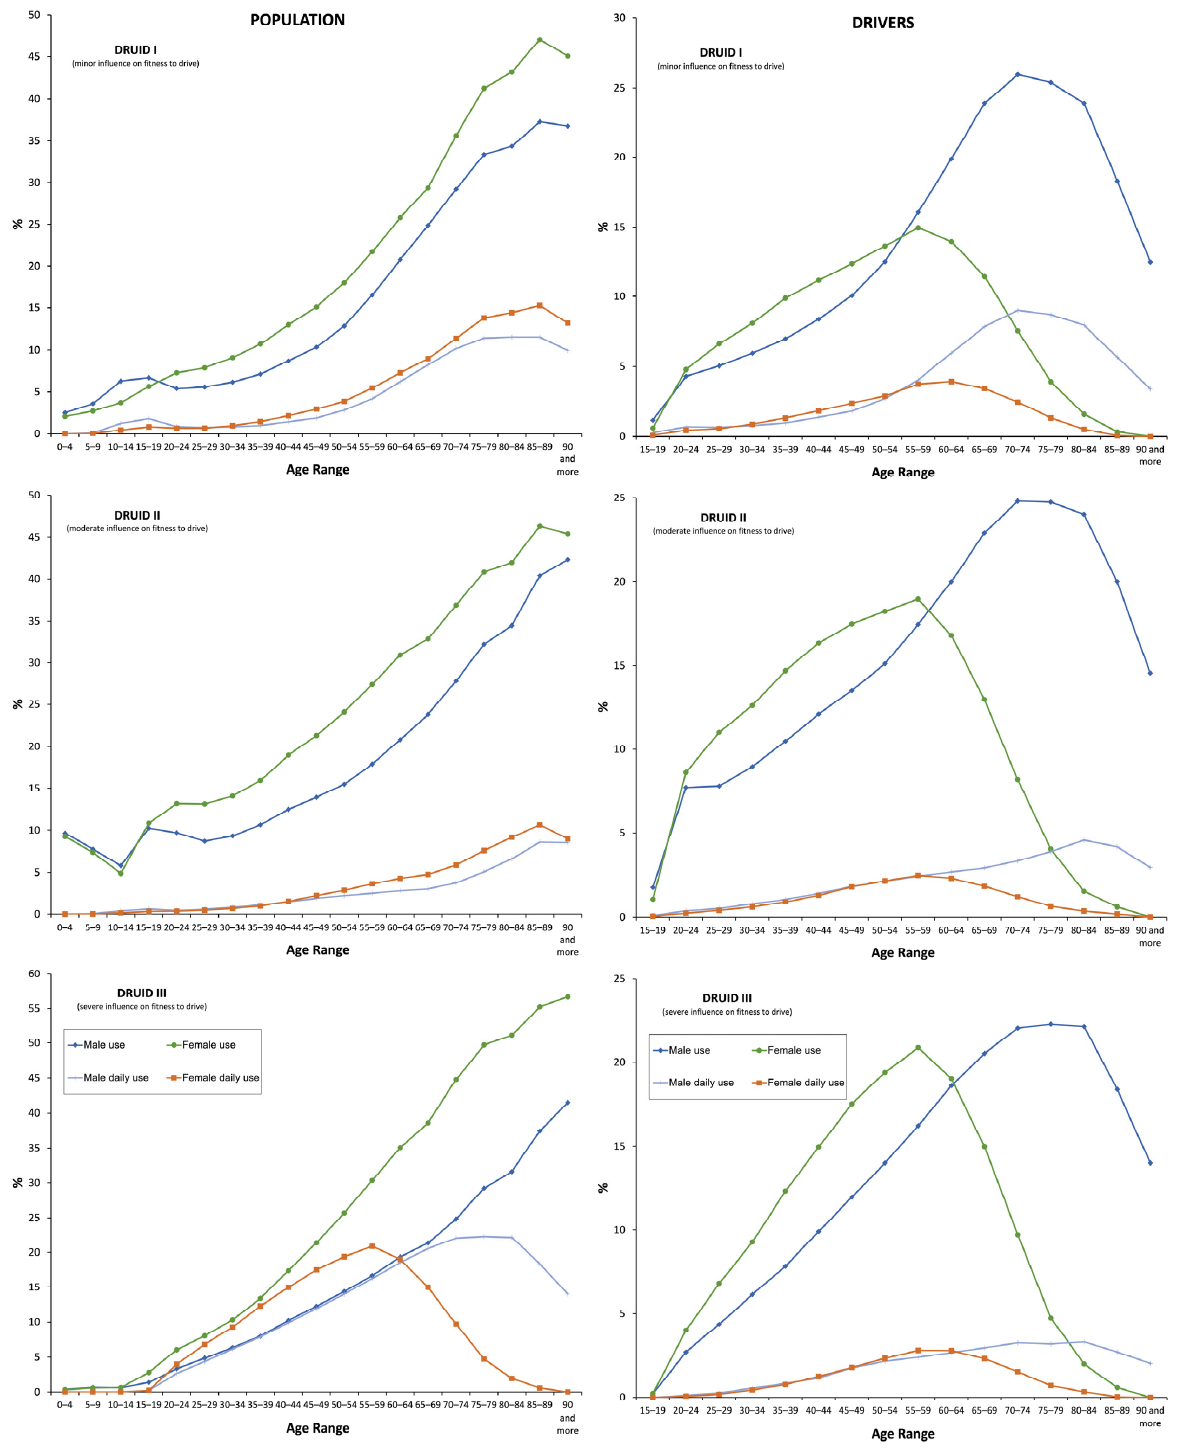
Figure 3. Frequency of the use of DIMs use by DRUID classification. The general population preferentially used DRUID II medicines (20.3%), followed by DRUID III medicines (19.08%) and DRUID I medicines (17.11%) (Table 1, Figure